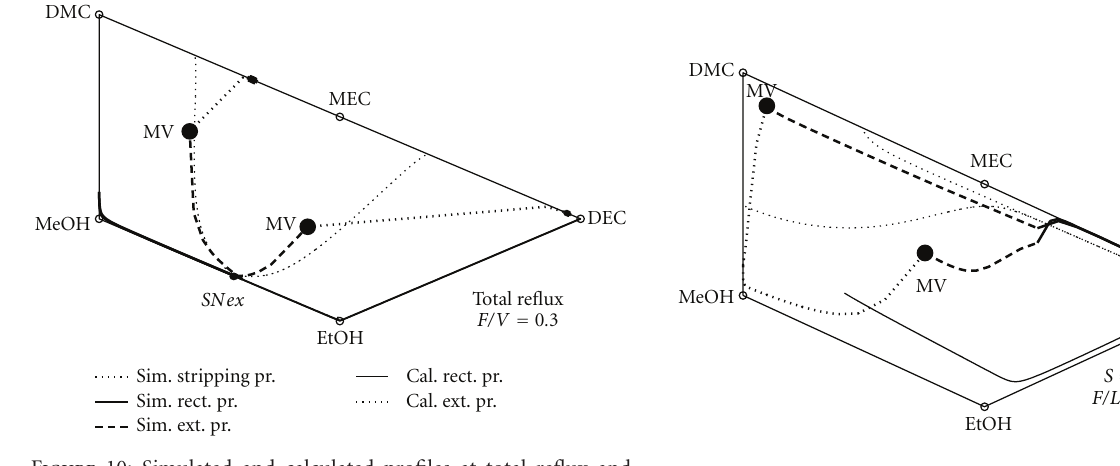
Figure 10: Simulated and calculated profiles at total reflux and reboil ratio, and at F d /V = 0 . 3.